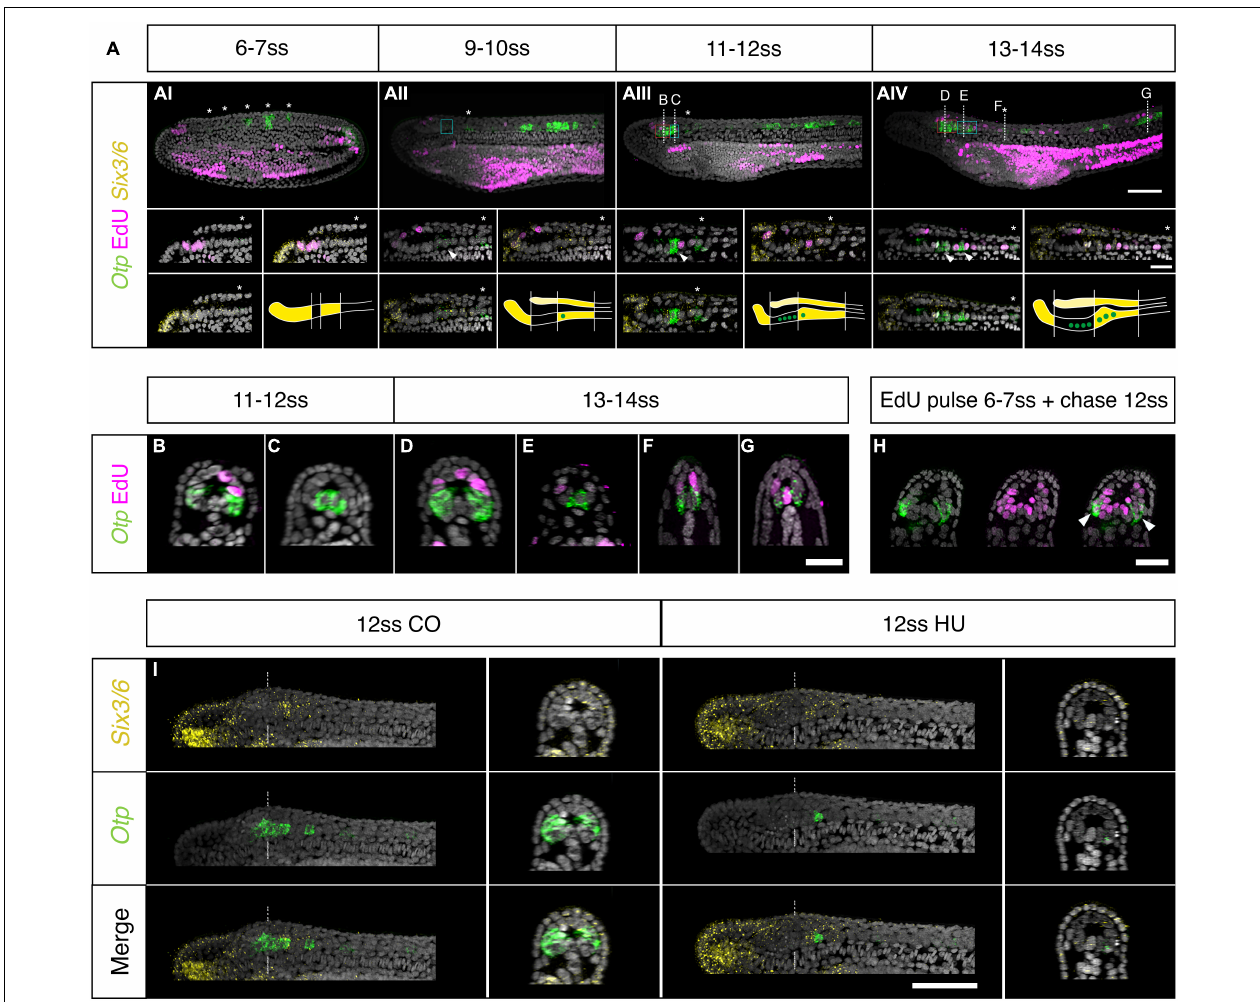
FIGURE 5 | Otp expression and brain proliferation during neurulation. (A) Co-detection of Otp and Six3/6 expression through HCR in situ hybridisation and EdU incorporation. (Ai) At 7 ss Otp is expressed in five clusters of cells in the trunk region (asterisks). Expression is strong in the posterior three clusters but very low in the anterior two clusters (asterisk in insets). (Aii) At 10 ss, a pair of Otp positive neurons appear in the posterior Six3/ 6 domain of cerebral vesicle (arrowhead in insets), but proliferation is still restricted to the anterior cerebral vesicle. (Aiii) At 12 ss two ventro-lateral clusters of Otp -positive cells are visible in the anterior cerebral vesicle. At this stage, cell division starts in the posterior cerebral vesicle; the posterior Otp -positive pair is not proliferating but cells adjacent to them are labelled by EdU (insets). (Aiv) At 14 ss, the number of posterior Otp -positive neurons increases (arrowhead). Asterisks in all insets show the first Otp cluster in the trunk. Patterns of Six3/6 and Otp co-expression are schematically representated at the bottom of each panel for every developmental stage. Scale bar is 50 µ m; 20 µ m for insets. (B–G) Cross section of 12 and 14 ss embryos showing the anterior ventro-lateral (B,D) , posterior medial (C,E) , and trunk (F,G) Otp cells. Scalebar: 20 µ m (H) 12 ss embryos EdU-pulsed at 7 ss show co-localization of EdU and Otp (arrowheads) at the level of D in panel (Aiv) . (I) Inhibition of cell division with 2 µ M hydroxyurea leads to a loss of the ventro-lateral Otp clusters in the Six3/6 -negative domain, while the posterior medial Otp cells are not affected. Scale bar is 50 µ m. EdU in magenta, Six3/6 in yellow, Otp in